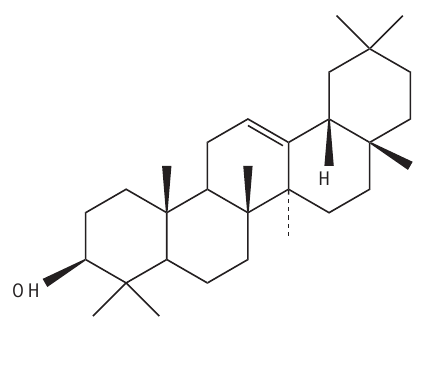
Figure 1. Structure of β